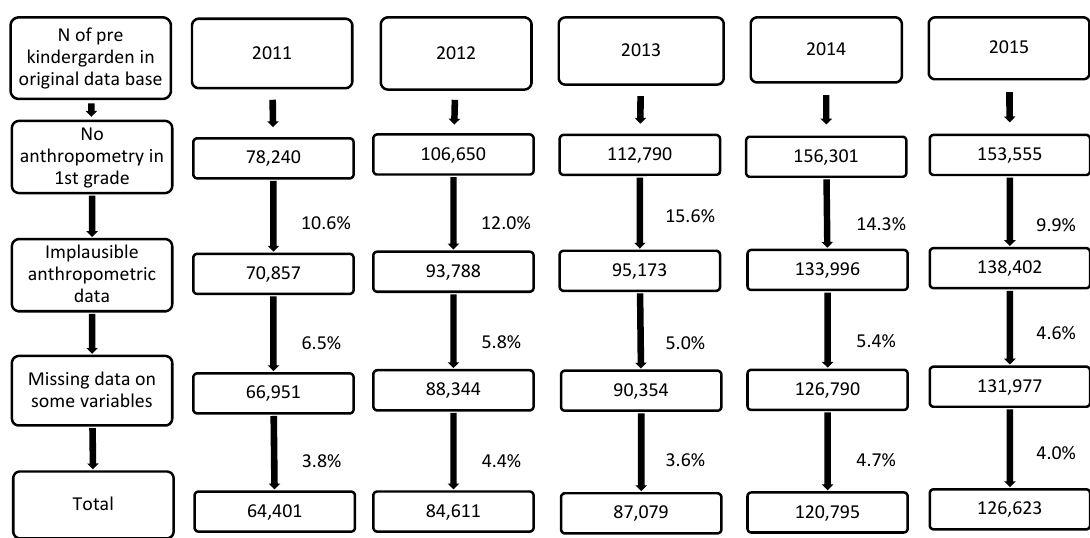
Figure 1. Population flow chart.